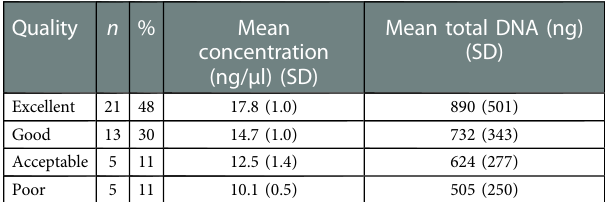
TABLE 2 DBS quality and DNA quanti fi cation. Quality Mean